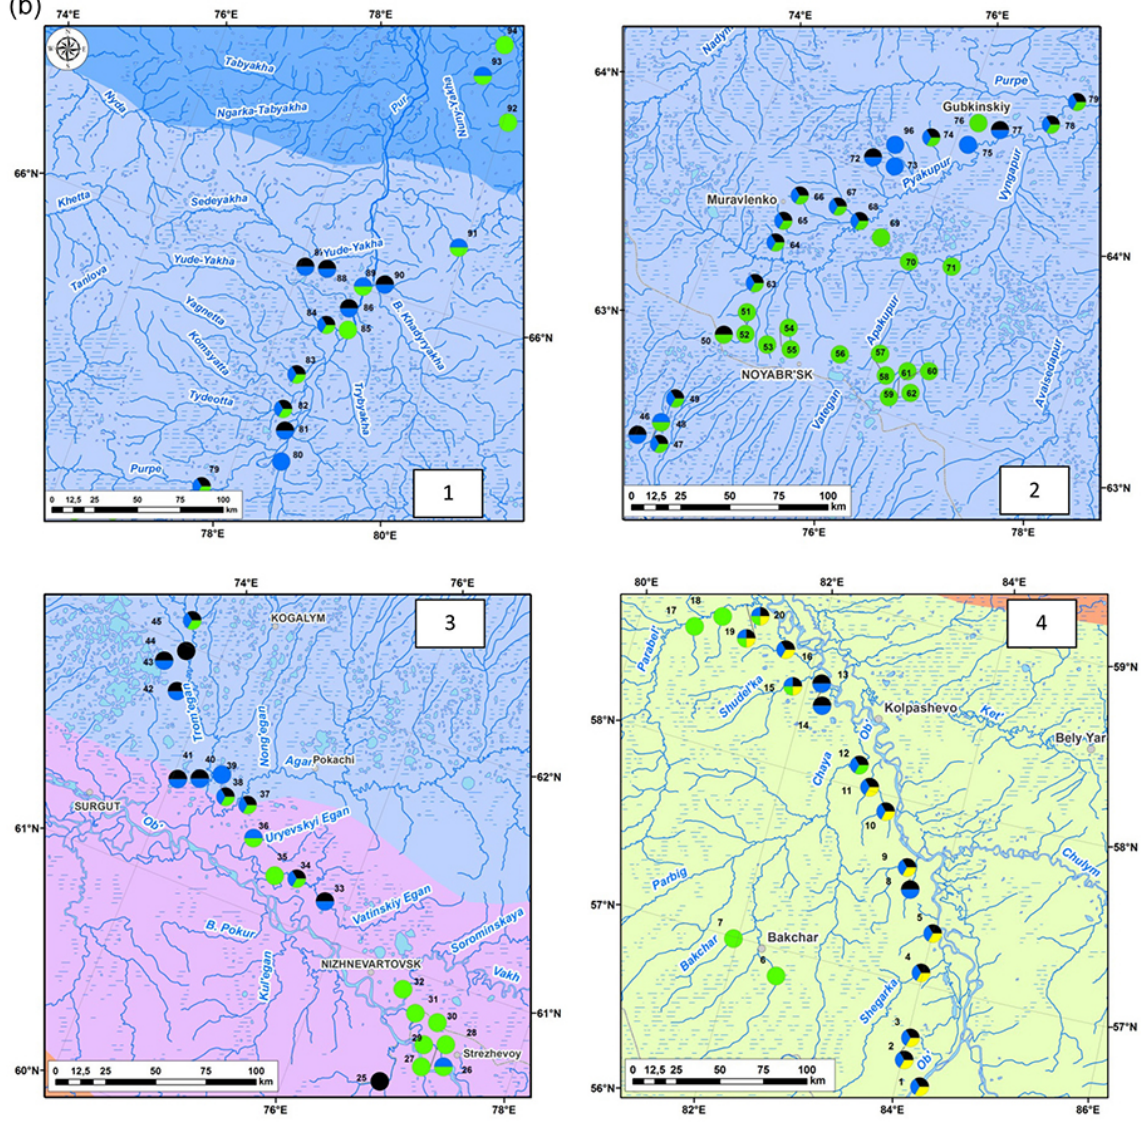
Figure 1. (a) Map of the study site with permafrost boundaries (Brown et al., 2002; http://portal.inter-map.com (NSIDC)), runoff contour lines (Nikitin and Zemtzov, 1986) and sampling points along the latitudinal transect of river basin of the Ob, Pur and Taz. The numbers of the sampling sites are listed in Table 1. (b) Detailed map of the four rectangles in (a) .